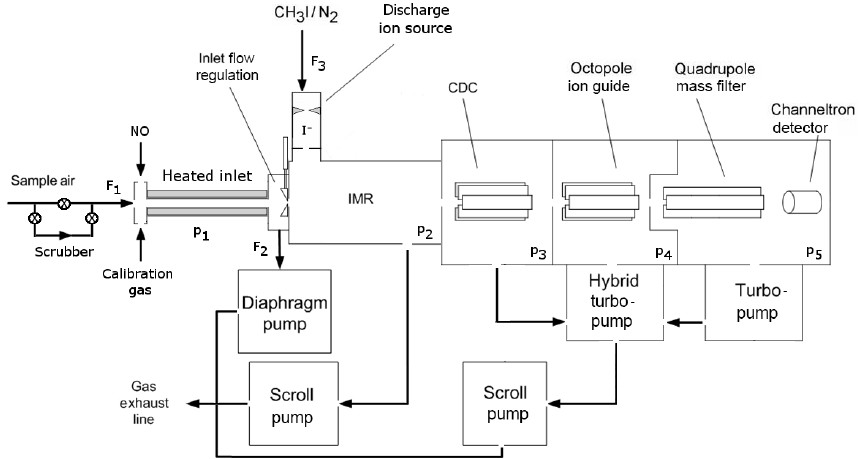
Figure 1. Schematic diagram of the CI-QMS. The air is sampled through the TDR (heated inlet) and enters the IMR after optional bypassing through the scrubber and mixing with calibration gas or nitrogen oxide (NO) for PAN background measurement. Ions are guided to the detector via the CDC, OCT and QMF. Typical flows ( F ) and pressures ( p ) are F 1 = 2 . 2, F 2 = 1 . 0, F 3 = 0 . 8slm, p 1 = ambient pressure,